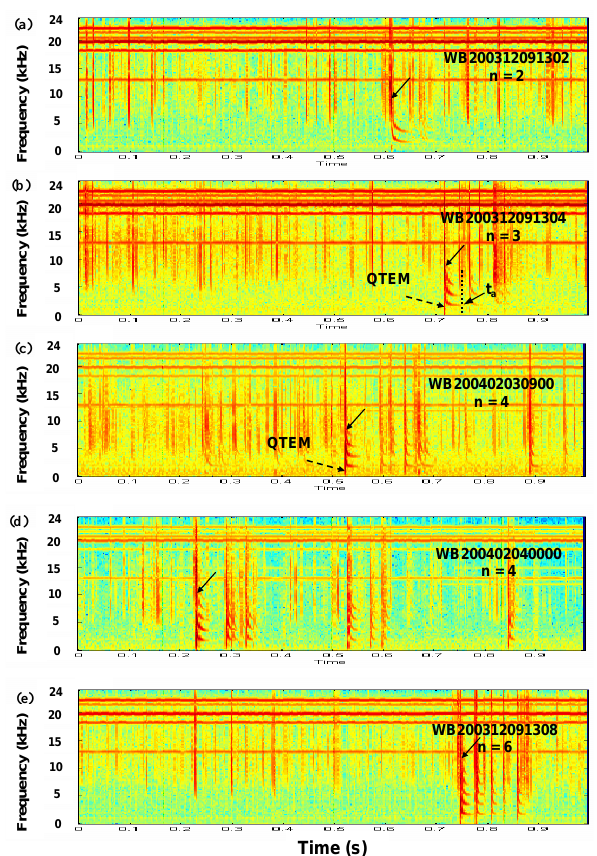
Fig. 1. Spectrograms of 1-s duration showing multimode tweek sferics observed at night labeled by the time of observation; e.g. WB200312091302 stands for year 2003, month 12, day 09, hour